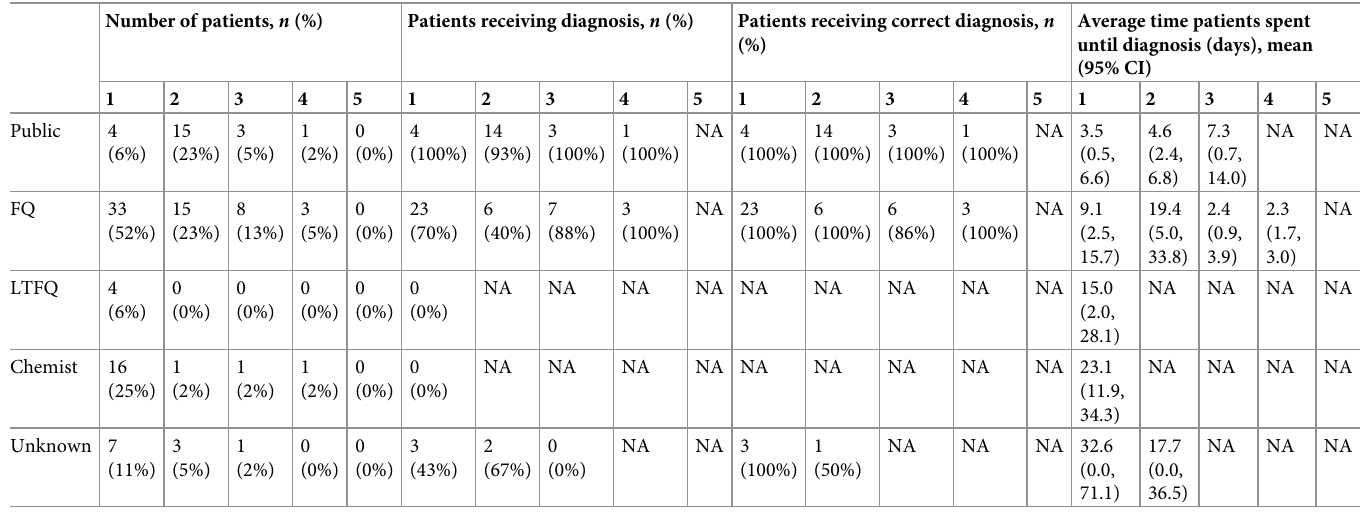
Table 4. Stage-wise descriptive statistics of patient pathway data: Patna. Number of patients, n (%)